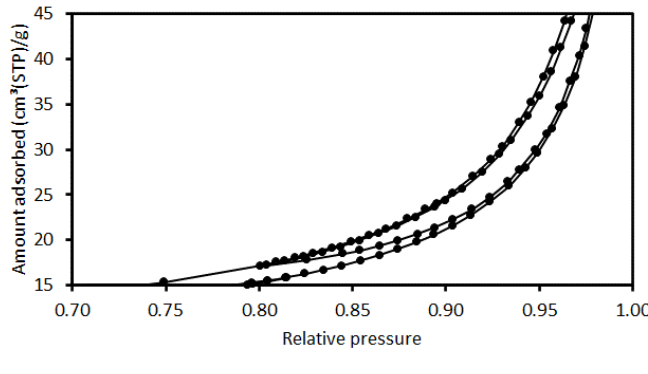
Figure 8. A series of nitrogen sorption scanning curves for as-received Nordland shale of particle size >150 μm, with ( a ) desorption starting at ultimate relative pressures of 0.99 ( ), 0.95( ), and 0.93 ( ) on the adsorption boundary isotherm; ( b ) a descending scanning curve starting at an ultimate relative pressure of 0.82 on the adsorption boundary isotherm; and ( c ) an ascending scanning curve springing from an ultimate relative pressure of 0.8 on the conventional desorption boundary isotherm. Reprinted from Seely et al. [68] under a Creative Commons CC-BY Licence.